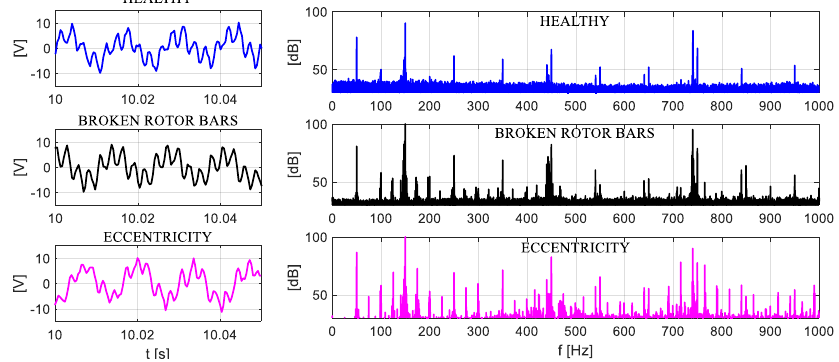
Figure 3. ZSV time waveforms and frequency spectra of the cage induction motor.